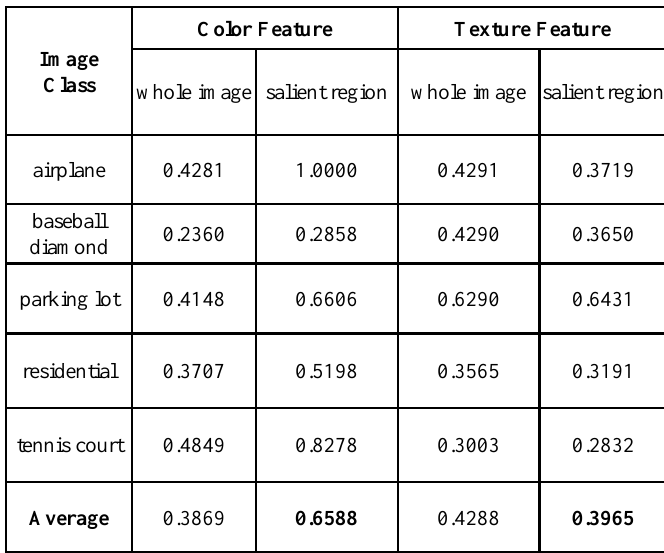
Table1. Retrieval precision of features extracted from whole image and salient region